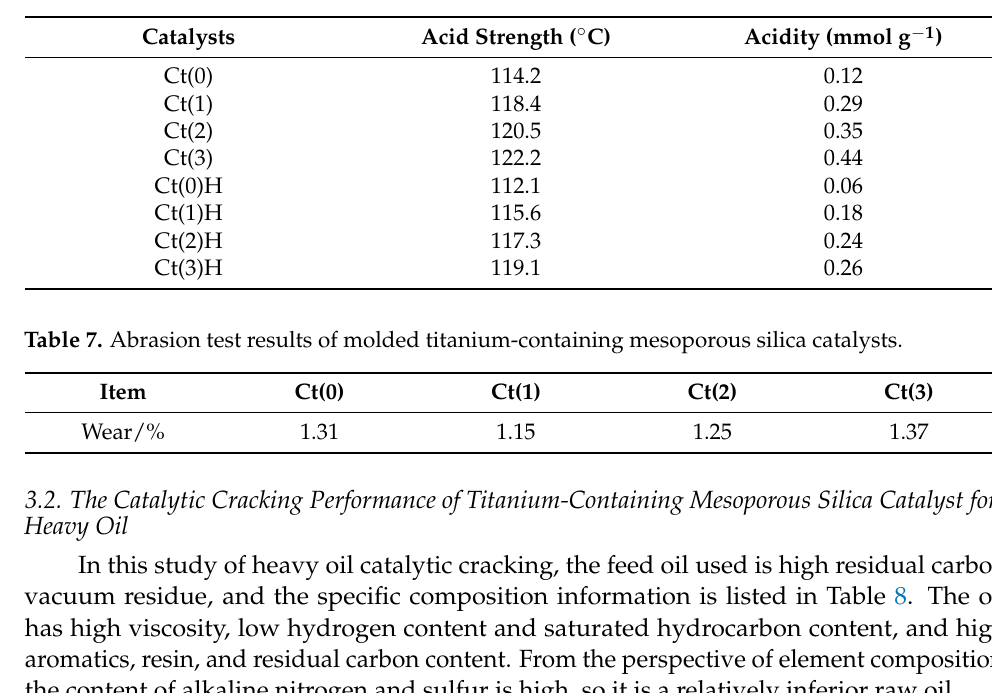
Table 6. Characterization results of NH 3 -TPD before and after hydrothermal treatment of mesoporous silica catalysts with different titanium contents after molding.